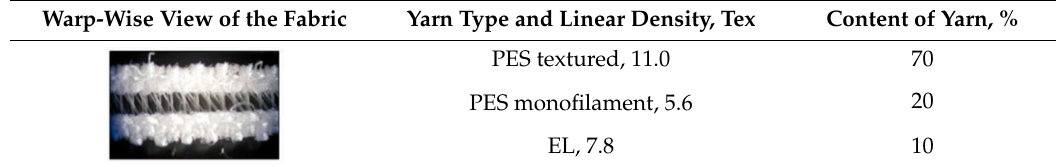
Table 1. Characteristics of three-dimensional warp-knitted spacer fabric C. Warp-Wise View of the